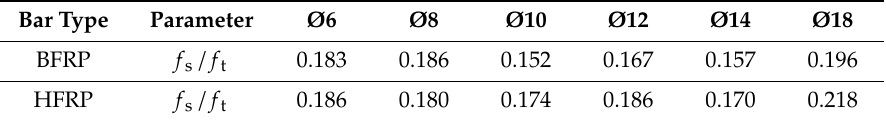
Table 6. Shear strength to tensile strength ratio.